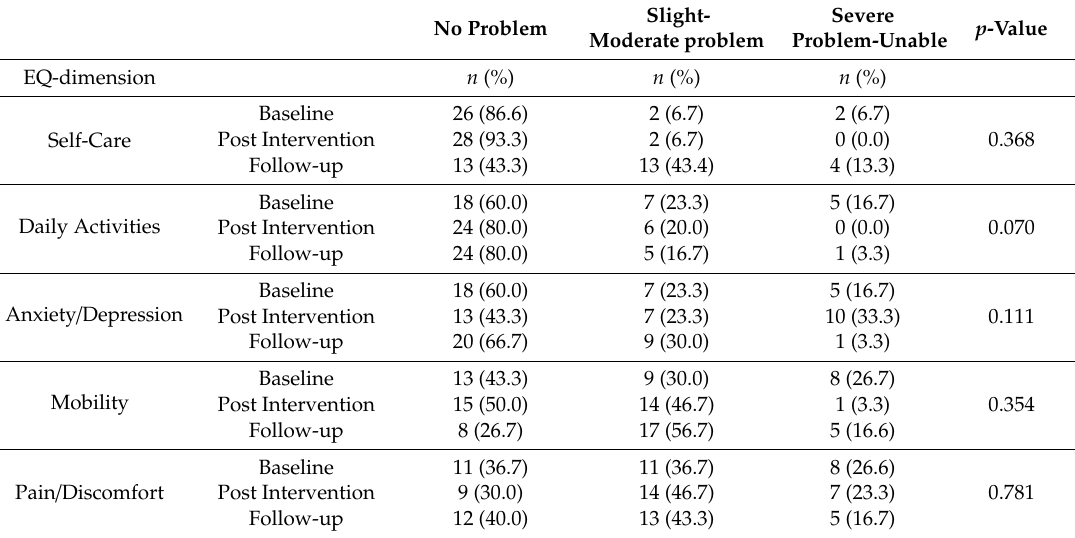
Table 3. EuroQOL 5D-5L Questionnaire ( n =